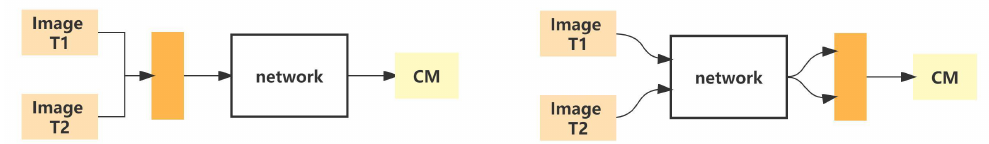
Figure 1. The diagram of the different fusion methods, image-level fusion ( left ) and feature-level fusion ( right ). The dark yellow square indicates the fusion method and the resulting Change Map